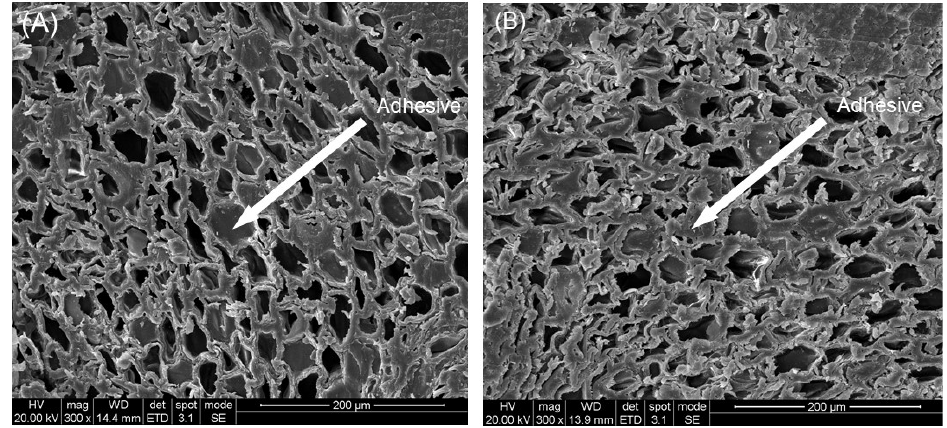
Figure 1. ( A ) The micromorphology of the bamboo scrimber before hot oil treatment; ( B ) the Figure micromorphology of the bamboo scrimber after hot oil treatment.